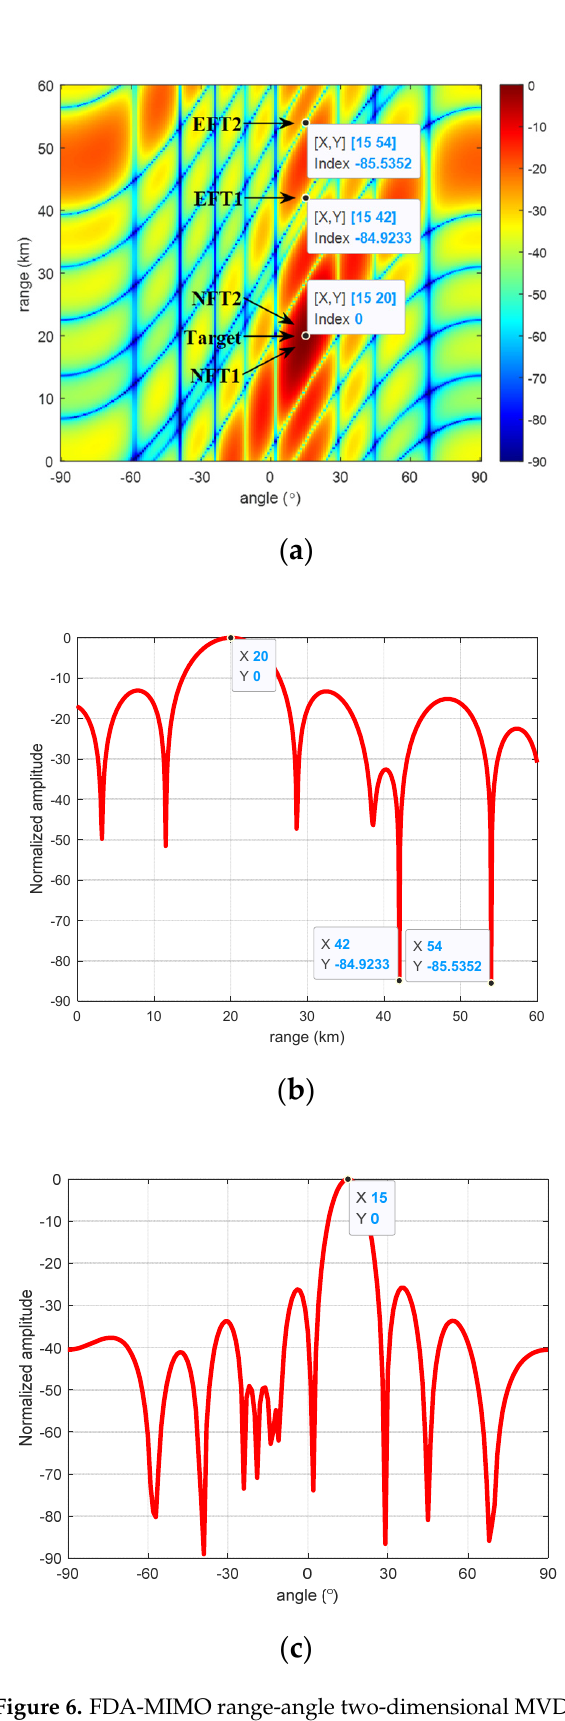
Figure 6. FDA-MIMO range-angle two-dimensional MVDR adaptive beamforming gain. ( a ) Range- angle two-dimensional beamforming gain; ( b ) Range dimension; ( c ) Angle dimension.